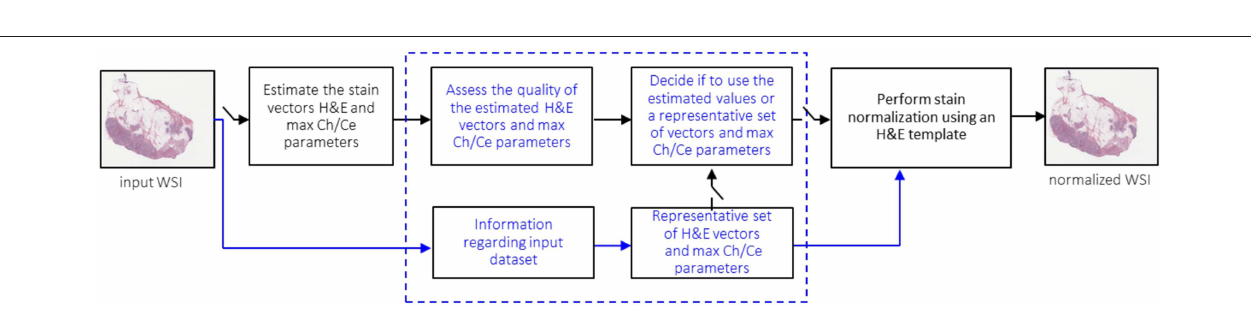
FIGURE 7 | Method to detect and handle problematic H&E estimation ( fast_rsn